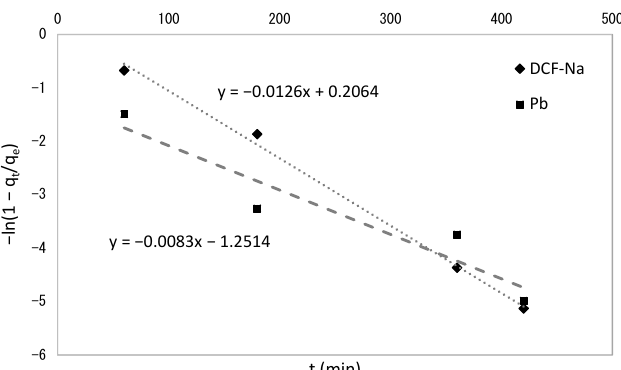
Figure 3. Film di ff usion plot for the simultaneous sorption process. Figure 3. Film diffusion plot for the simultaneous sorption